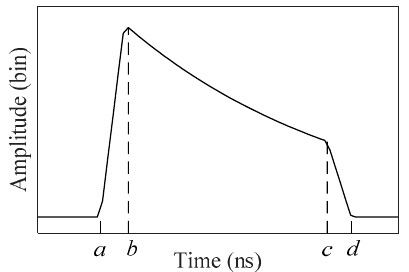
5 of 11 Figure 9. Calibration waveform (solid) and fitting curves (dashed) with Gaussian, exponential and